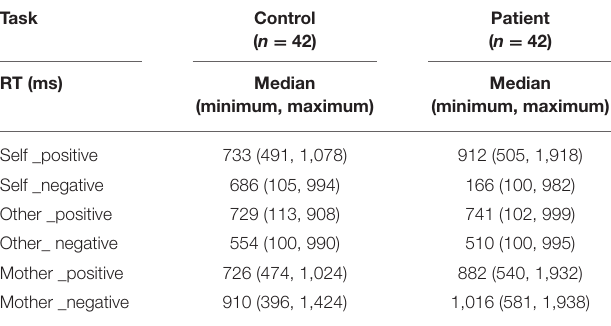
TABLE 3 | Encoding RT data for healthy controls and first-episode schizophrenia patients.